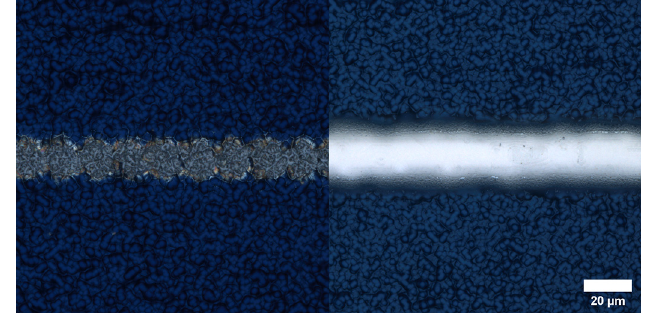
Fig. 2. Top view microscope image of the laser contact opening (left) with a width of about 15 m m and a plated Ni/Cu/Ag fi nger with a fi nger height of 10 m m and a fi nger width of 24 m m